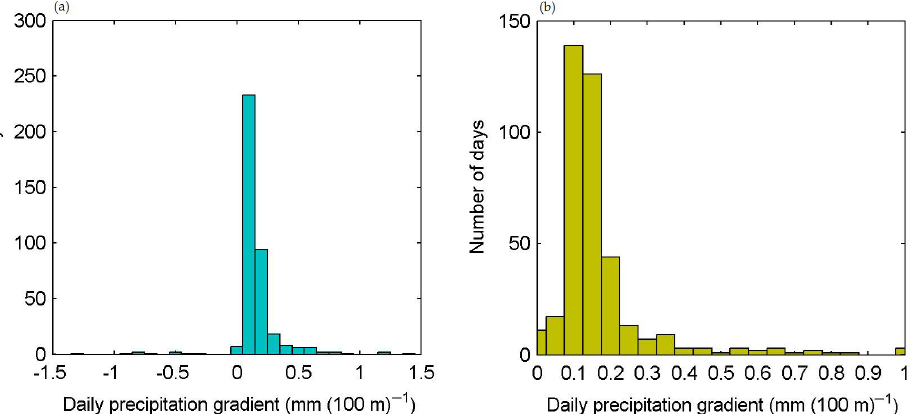
Figure 6. The histogram of measured daily precipitation gradients using observed daily precipitation at the AWS and Shiquanhe station. Intervals in plot ( a ) is 0.1 mm (100 m) − 1 . Plot ( b ) shows the range of 0 − 1 mm (100 m) − 1 with an interval of 0.05 mm (100 m) − 1